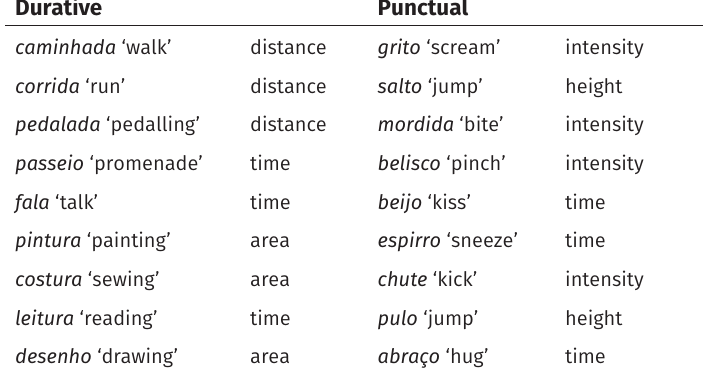
Table 3: Most selected non-number dimensions in the second stimuli norming study and included in the main